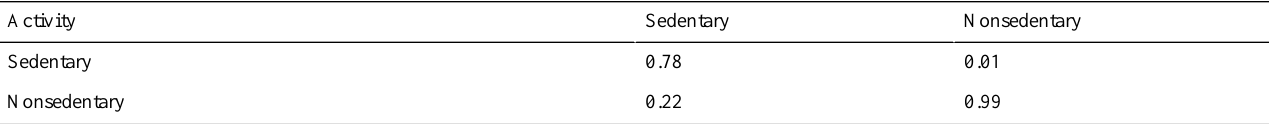
Table 9. Normalized confusion matrix showing percentage of correctly classified instances for the random forest model used for activity type classification tasks based on sedentary. Each column shows the actual activity and rows represent the predicted labels.